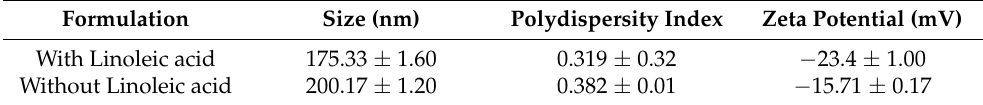
Table 3. Effect of incorporation of linoleic acid on the stability of